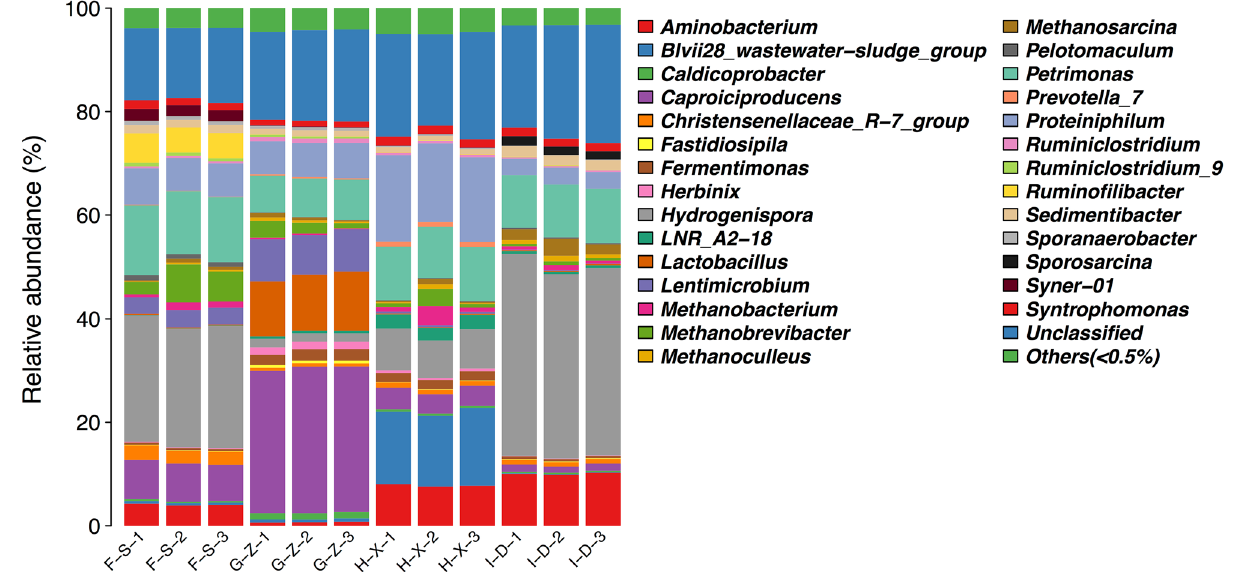
Figure 4. Stack diagram showing the species distribution of bacteria in pit mud from F-S, G-Z, H-X and I-D at the genus level.